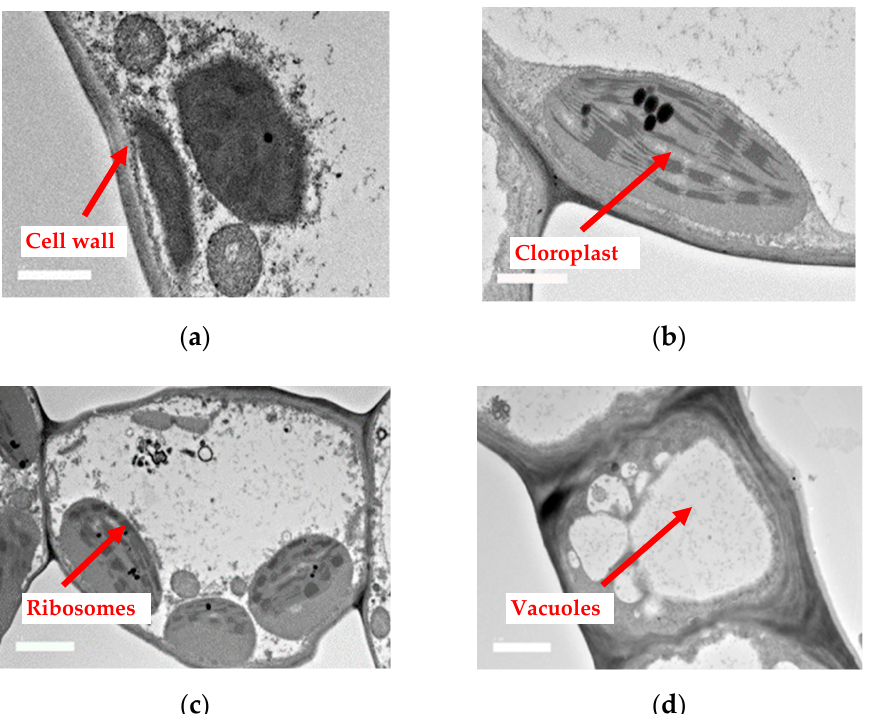
Figure 4. Transmission electron microscopy (TEM) analysis of leaf tissues from pennywort leaves ( a ) cell wall, ( b ) chloroplasts, ( c ) ribosomes and ( d ) vacuole.